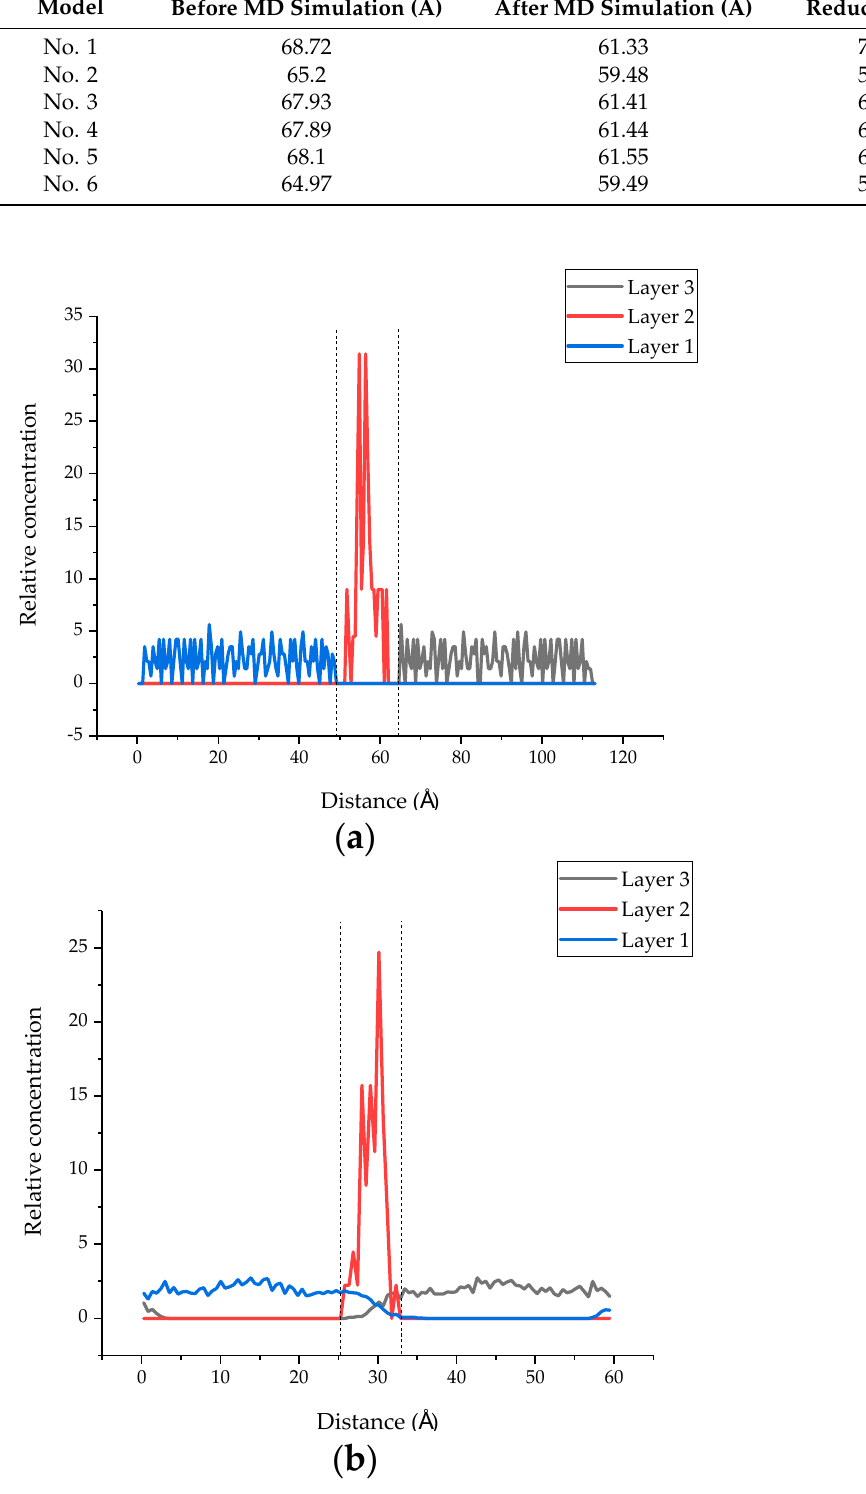
Figure 10. The relative concentration distribution before and after MD simulation (layer 1 and layer 3 are the tobermorite layers, and layer 2 is the epoxy resin layer). ( a ) The relative concentration distribution of the original model. ( b ) The relative concentration distribution after MD